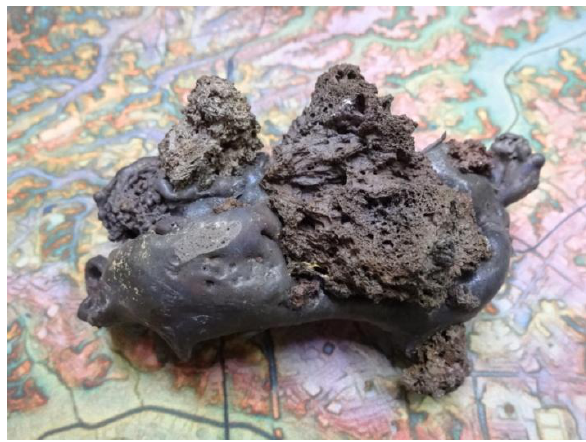
Figure 2. Point classification by PCA Figure 3. The test object: lava stone of Izu Oshima